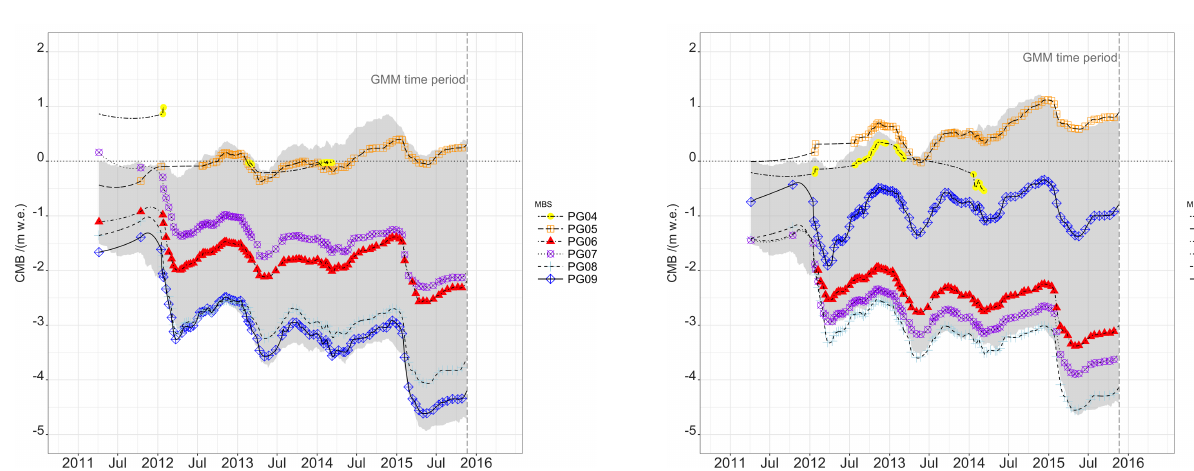
Figure 8. Shown is the cumulative mass balance in mw.e. (water equivalent) measured at the calibration mass balance stake transect PG0 x on the Fourcade Glacier, Potter Peninsula, during the time period November 2011 to May 2016. The location of the individ- ual stakes is shown in Fig. 1. The lines are interpolation lines be- tween observation points. The grey shade indicates the spread of the GMM-simulated cumulative mass balance at the stake locations PG05 to PG08.